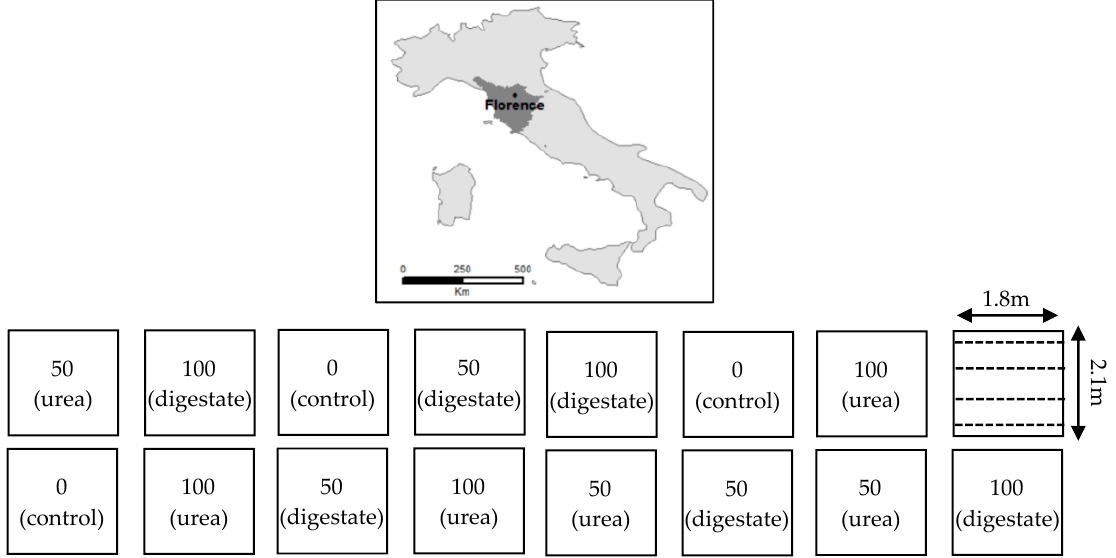
Figure 1. Location of the experimental site and research design with di ff erent N fertilization levels (100 / 50 kg N ha − 1 urea, 100 / 50 kg N ha − 1 digestate, and 0 kg N ha − 1